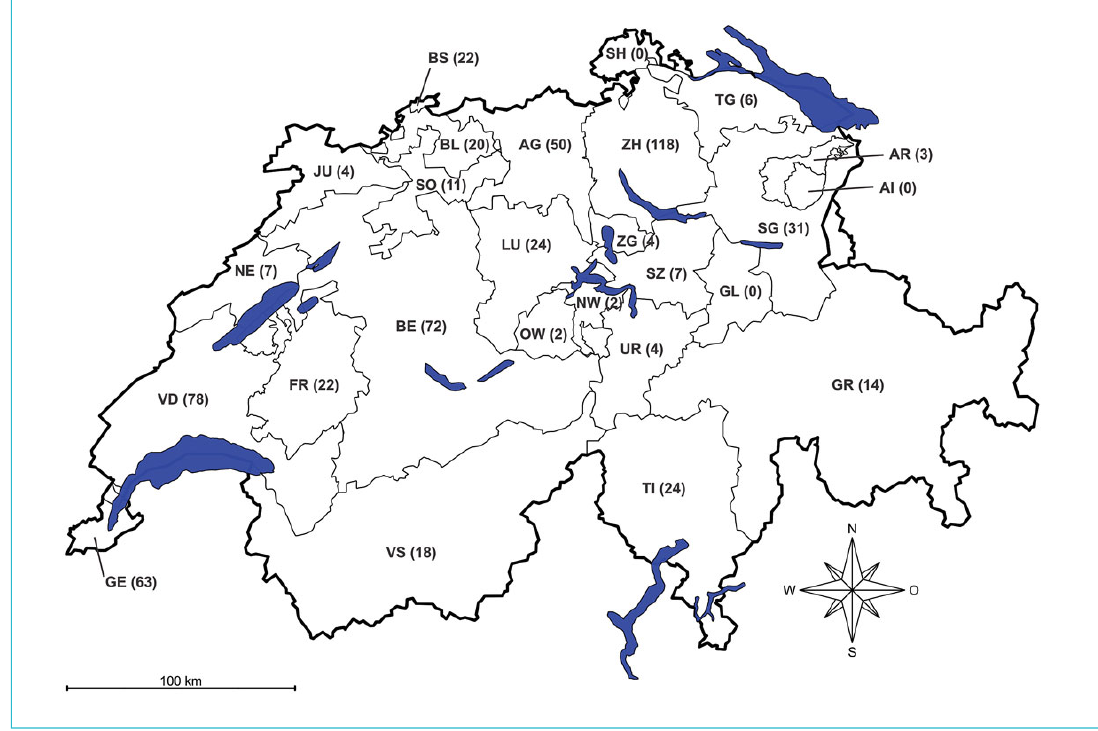
Figure 1: Switzerland and its cantons, regional workplace distribution indicated by respondents to the survey.